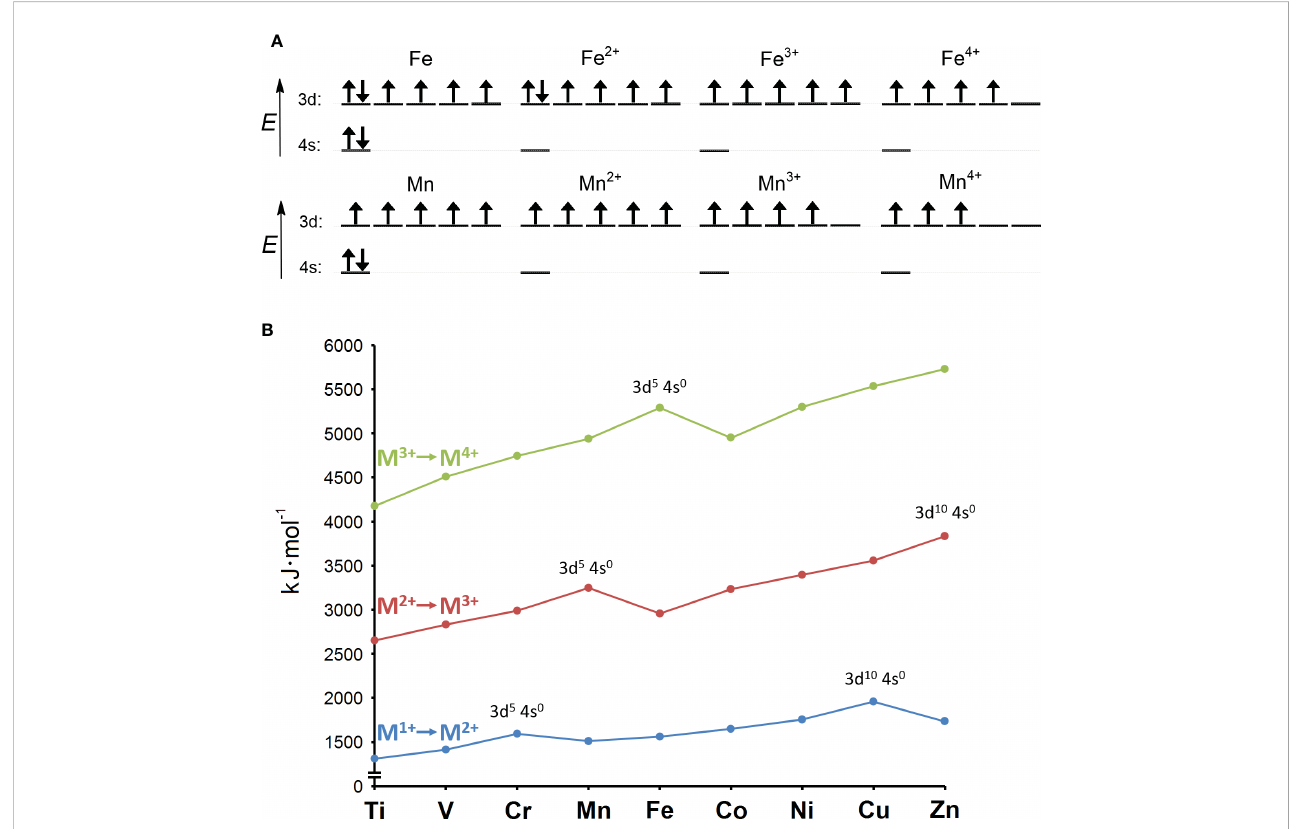
FIGURE 1 (A) Electron con fi gurations of iron and manganese atoms and their +2, +3, and +4 oxidation states. The con fi gurations of the +2 and +3 oxidation states for iron and manganese correspond to the starting ions in the ionization scheme shown in panel (B). (B) Second (M 1+ to M 2+ ; in blue), third (M 2+ to M 3+ ; in red) and fourth (M 3+ to M 4+ ; in green) ionization energies of the fi rst-row transition metals. The ionization energy is the work required to remove an electron from an atom or ion, and it increases toward higher atomic numbers within a single valence shell. This rule is violated by half- fi lled (3d 5 4s 0 ) and fully fi lled d-orbitals (3d 10 4s 0 ), which have a higher ionization energy than the following atom or ion with a higher atomic number. This is because symmetric half- fi lled or fully fi lled orbitals are stabilized by released exchange and pairing energies, which ultimately impedes their further oxidation. Mn 2+ is stabilized and therefore dif fi cult to oxidize because it has symmetric 3d 5 4s 0 con fi guration, while Fe 2+ has asymmetric 3d 6 4s 0 con fi guration and is therefore easier to oxidize. On the other hand, the half- fi lled 3d 5 4s 0 con fi guration of Fe 3+ renders this ion more resistant to further oxidation compared to the asymmetric 3d 4 4s 0 con fi guration of Mn 3+ . Adapted from Lang and Smith